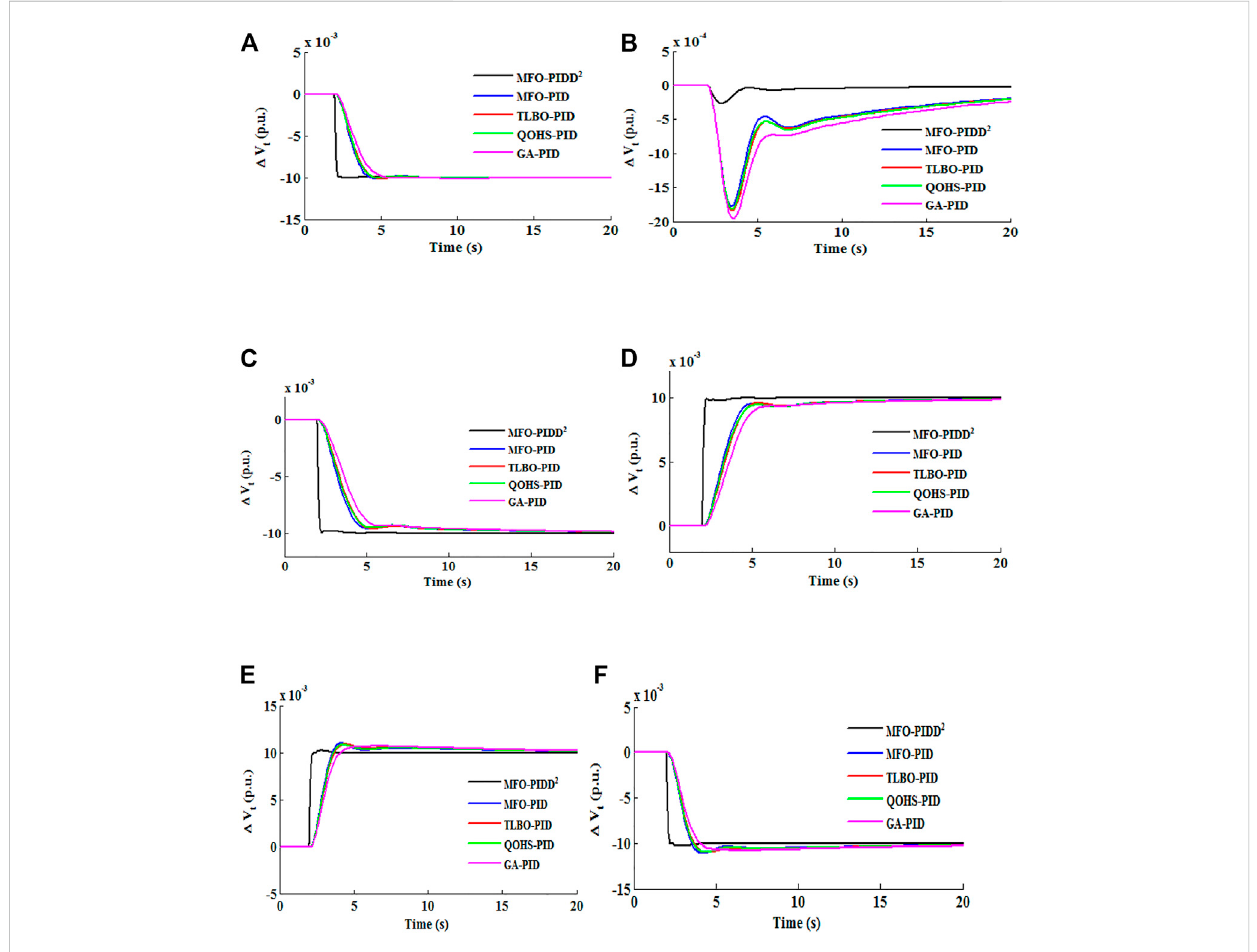
FIGURE 6 Comparison of transient characteristics for distinct disturbances at K G (cid:2) 1 . 0 and τ G (cid:2) 1 . 0 s. (A) Δ V ref (cid:2) − 0 . 01 , Δ P d (cid:2) 0 . 00, (B) Δ